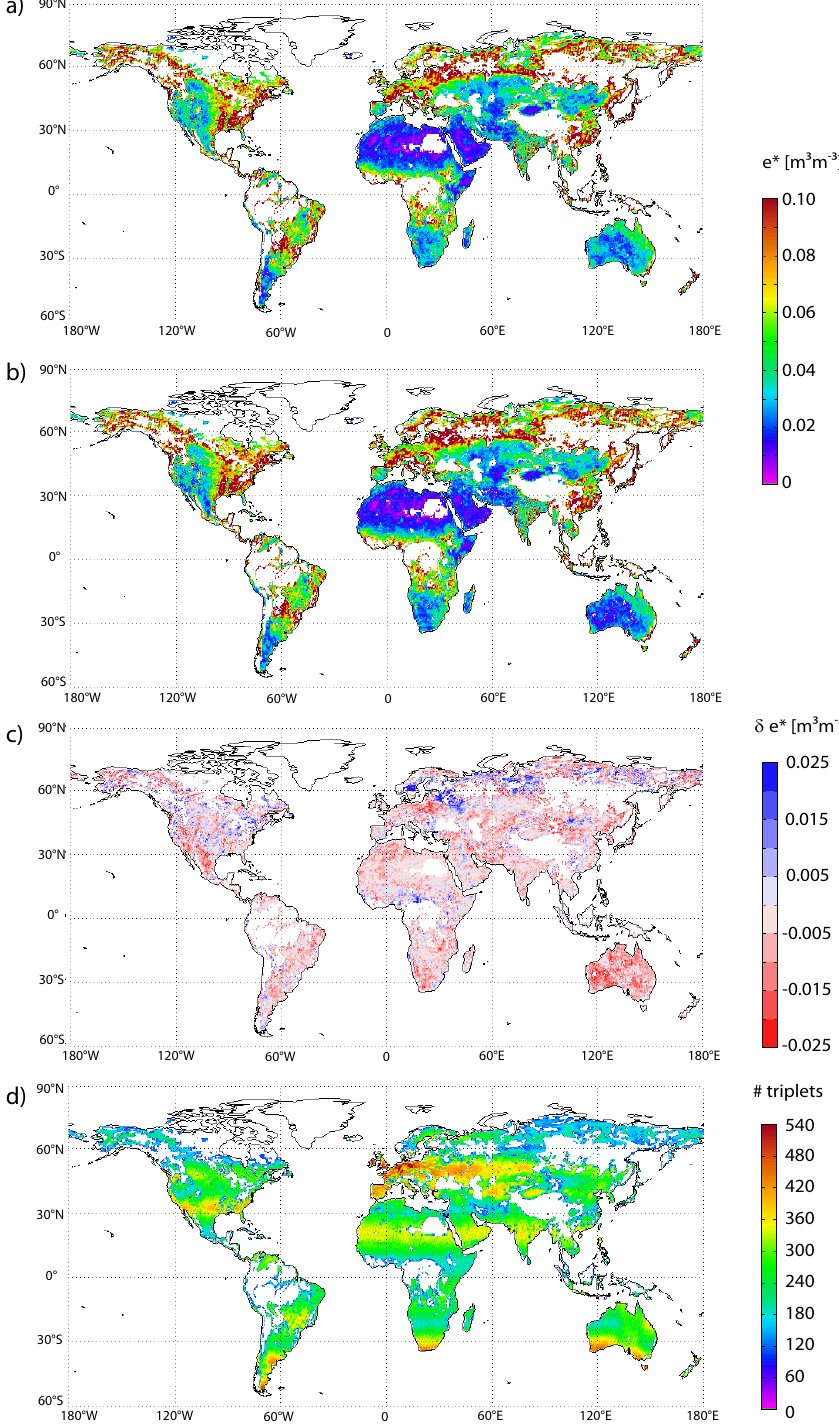
Fig. 3. (a) Spatial errors e ∗ obtained with a combination of ASCAT, AMSR-E C-band, and ERA-Interim. (b) Spatial errors e ∗ PAS with a combination of ASCAT, AMSR-E C-band, and GLDAS-NOAH. Both in (a) and (b) errors are expressed in the climatology of AMSR-E. (c) Difference between AMSR-E C-band errors obtained using GLDAS-NOAH and using ERA-Interim as third independent soil moisture dataset, respectively. (d) Number of